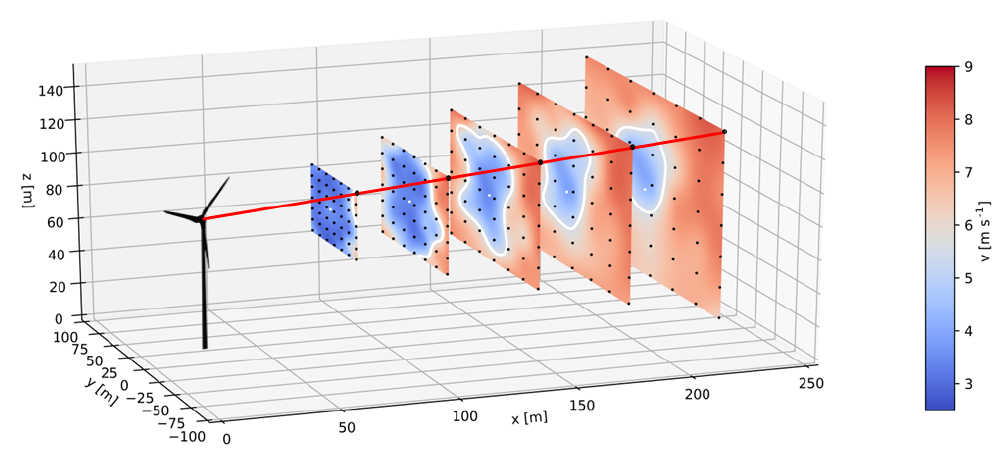
Figure 2. Lidar scan pattern used at the five locations downstream of the turbine.